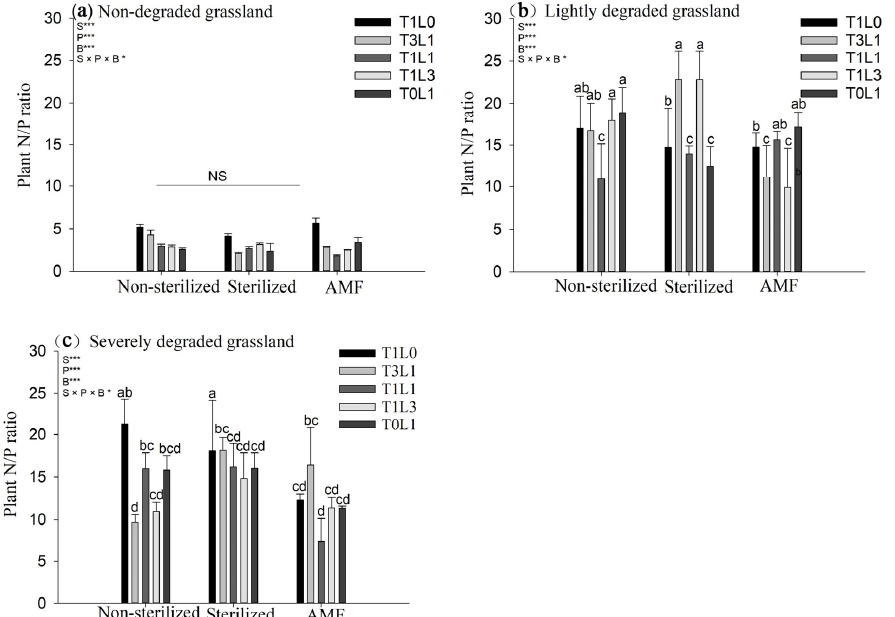
Figure 5. Effects of different treatments on plant N/P ratio. (a) Effects of soil type (S), planting ratio (P) , biological treatment (B) and their interactions (S × P × B) on plant N/P ratio in non- degraded grassland soil (b) Effects of soil type (S), planting ratio (P) , biological treatment (B) and